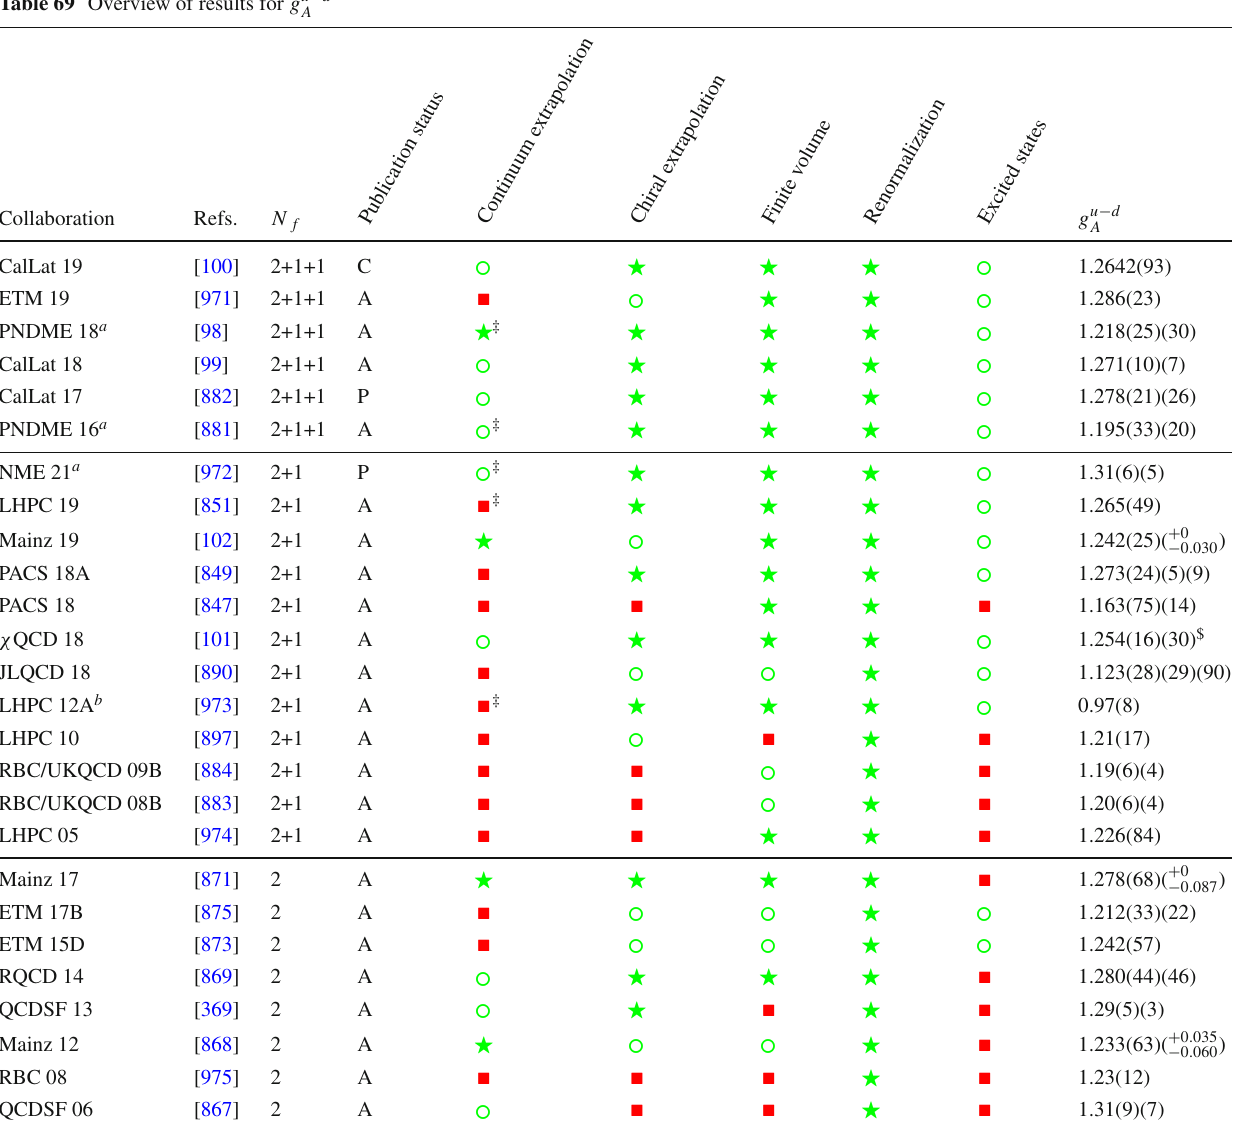
Table 69 Overview of results for g u − d